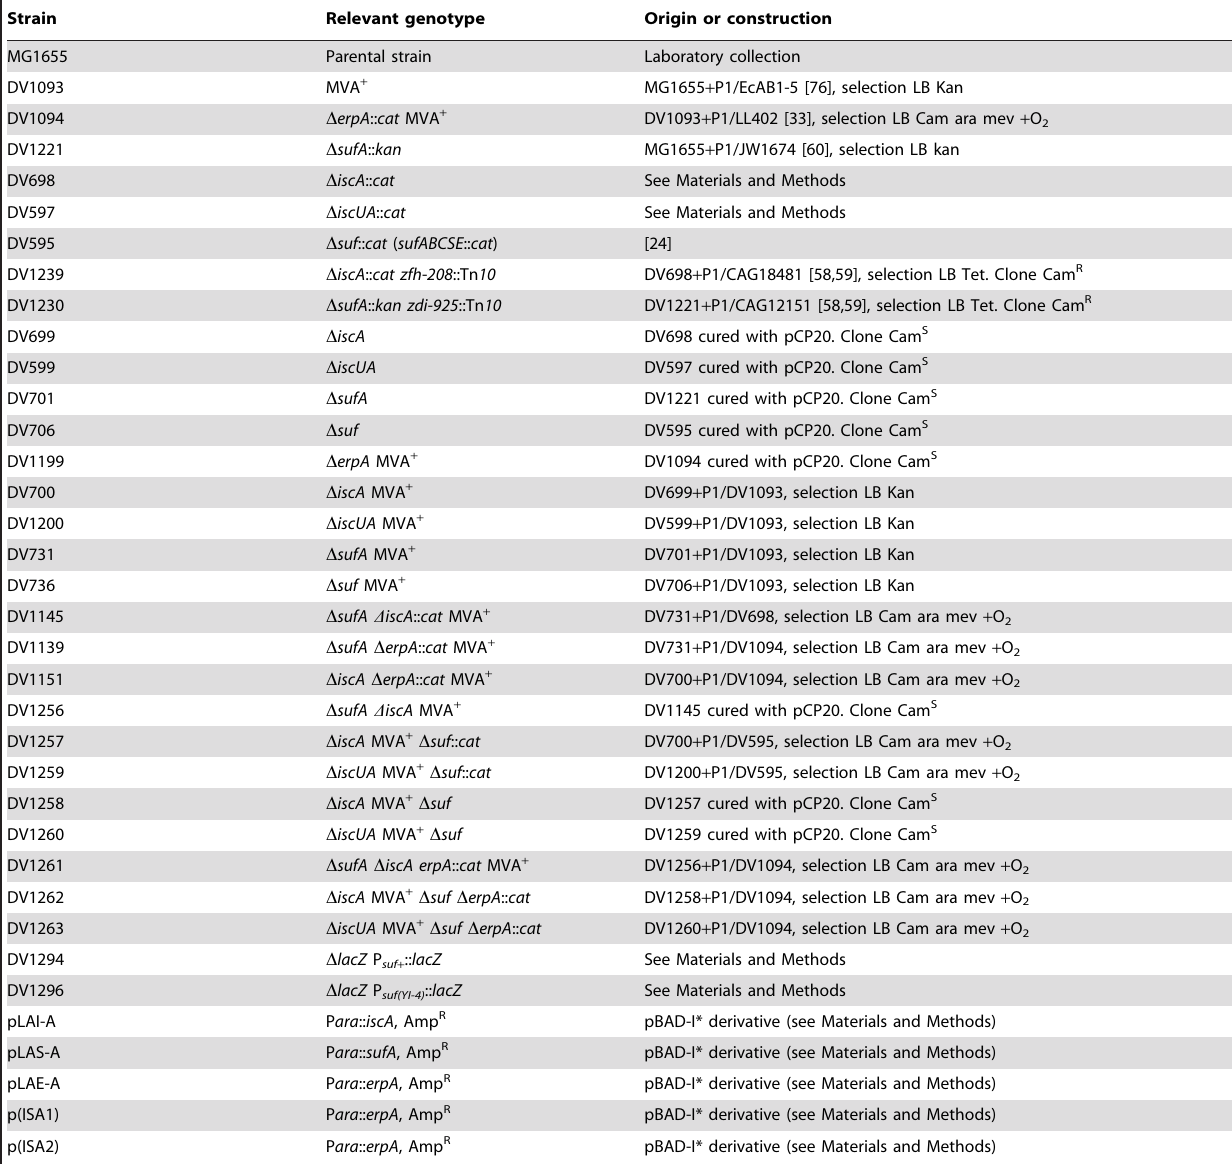
Table 7. Bacterial strains and